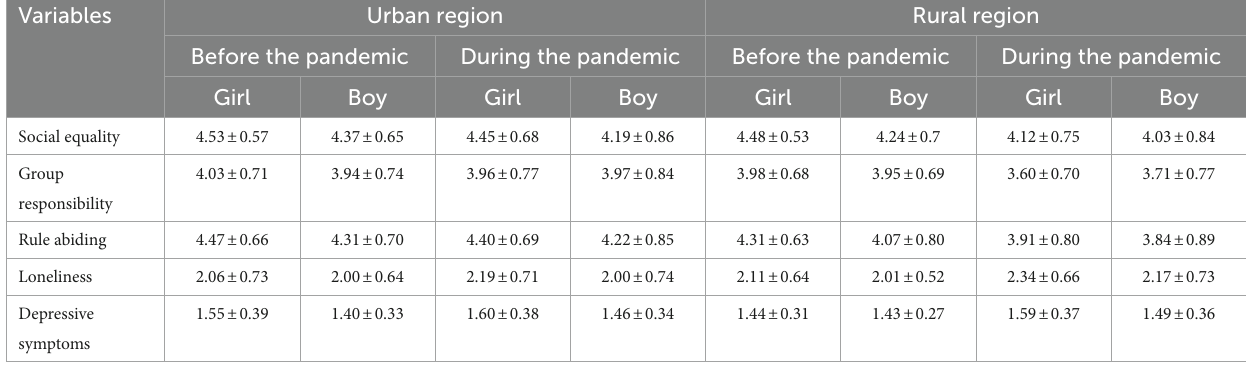
TABLE 3 Means and standard deviations of group orientation and mental health problems(M ± SD).